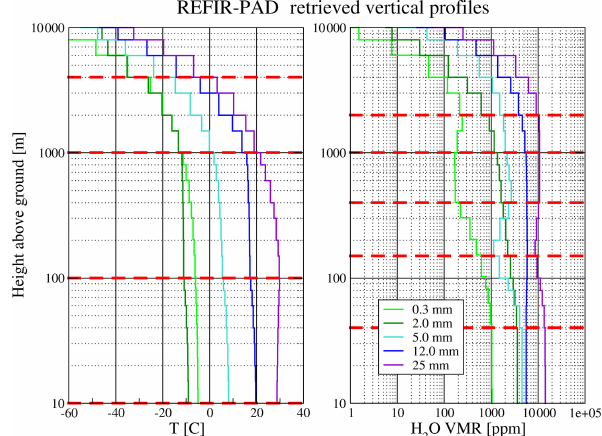
Figure 15. Vertical temperature and water vapor profiles obtained from the spectra in Fig. 13a, through the level 2 data analysis pro- cess. Red dashed lines show the selected fitting layers for tempera- ture and water vapor.